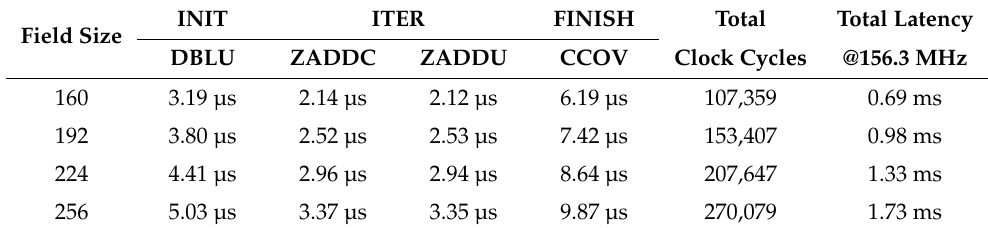
Table 4. Performance of proposed ECSM architecture on Kintex-7.